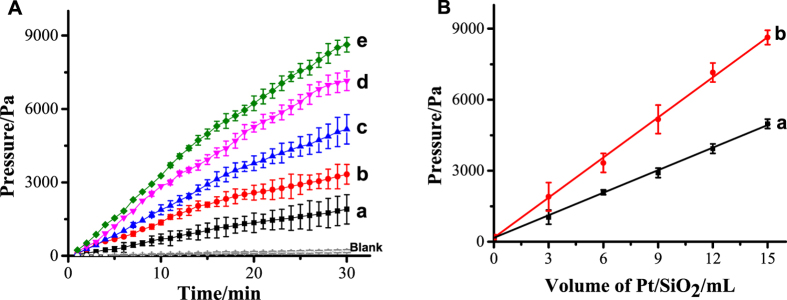
(A) Time-dependent changes in pressure with different volume of Pt/SiO2 (1.00 mg/mL):Blank 0, (a) 3, (b) 6, (c) 9, (d) 12,(e) 15 μL in the tiny outfit containing 4 mL of 1.6 mol●L−1 H2O2. (B): the linear relationship between pressure signal and the volume of Pt/SiO2 at different reaction time, 15 min (a) and 30 min (b).